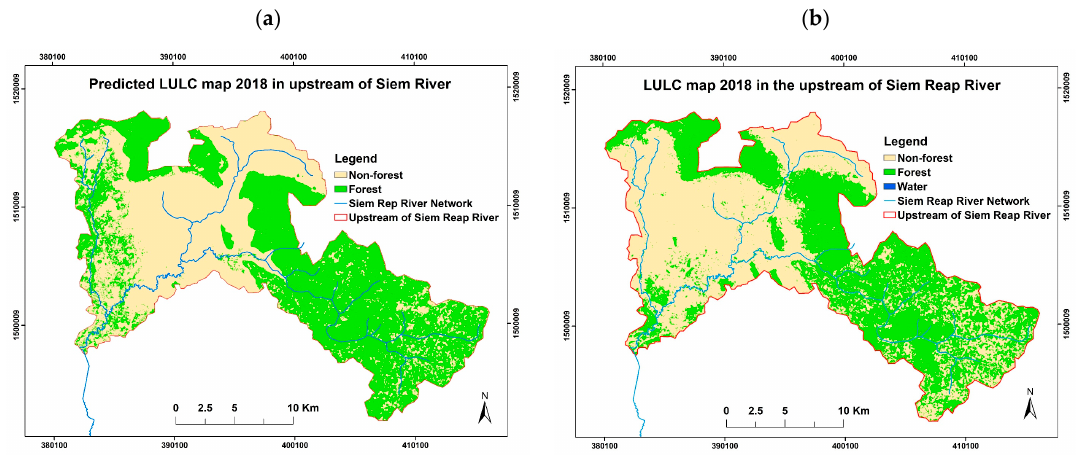
Figure 9. Predicted ( a ) and actual ( b ) LULC maps 2018.